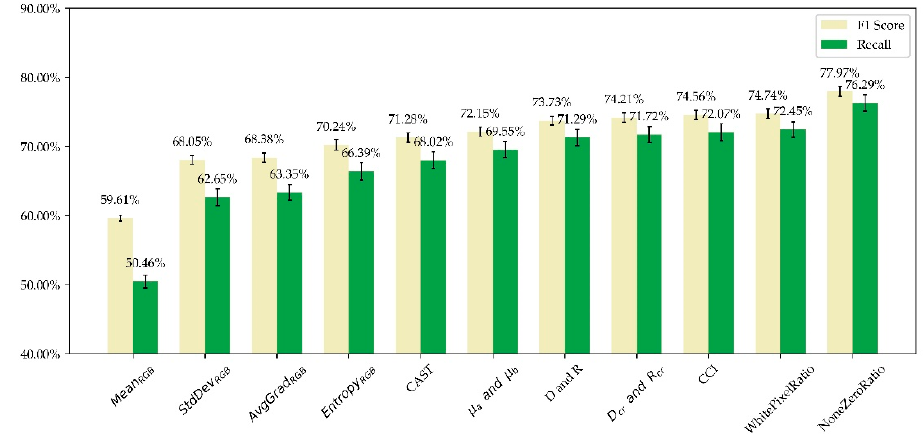
Figure 5. Results of growing study. Features were added to the input group by group. The results are the mean values obtained through 300 times of tests, and the black vertical disconnections indicate ± standard deviation. F1 score and recall “increase” with the growing features, indicating the effectiveness of our designed features.